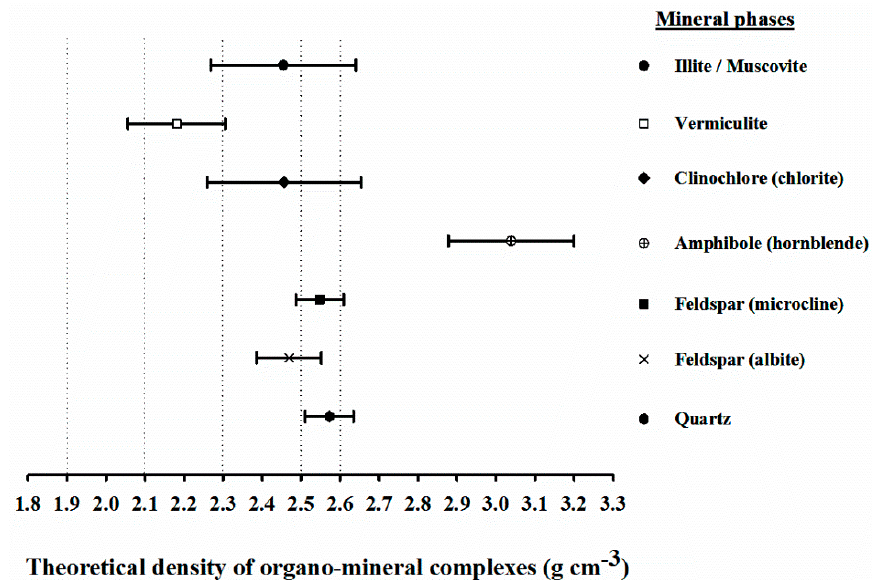
Figure A1. Theoretical densities of organo-mineral complexes associated with soil minerals. Horizontal bars are standard deviations from the means calculated in Tables A1 and A2 (see above). Dotted lines are thresholds for the sequential density separation.